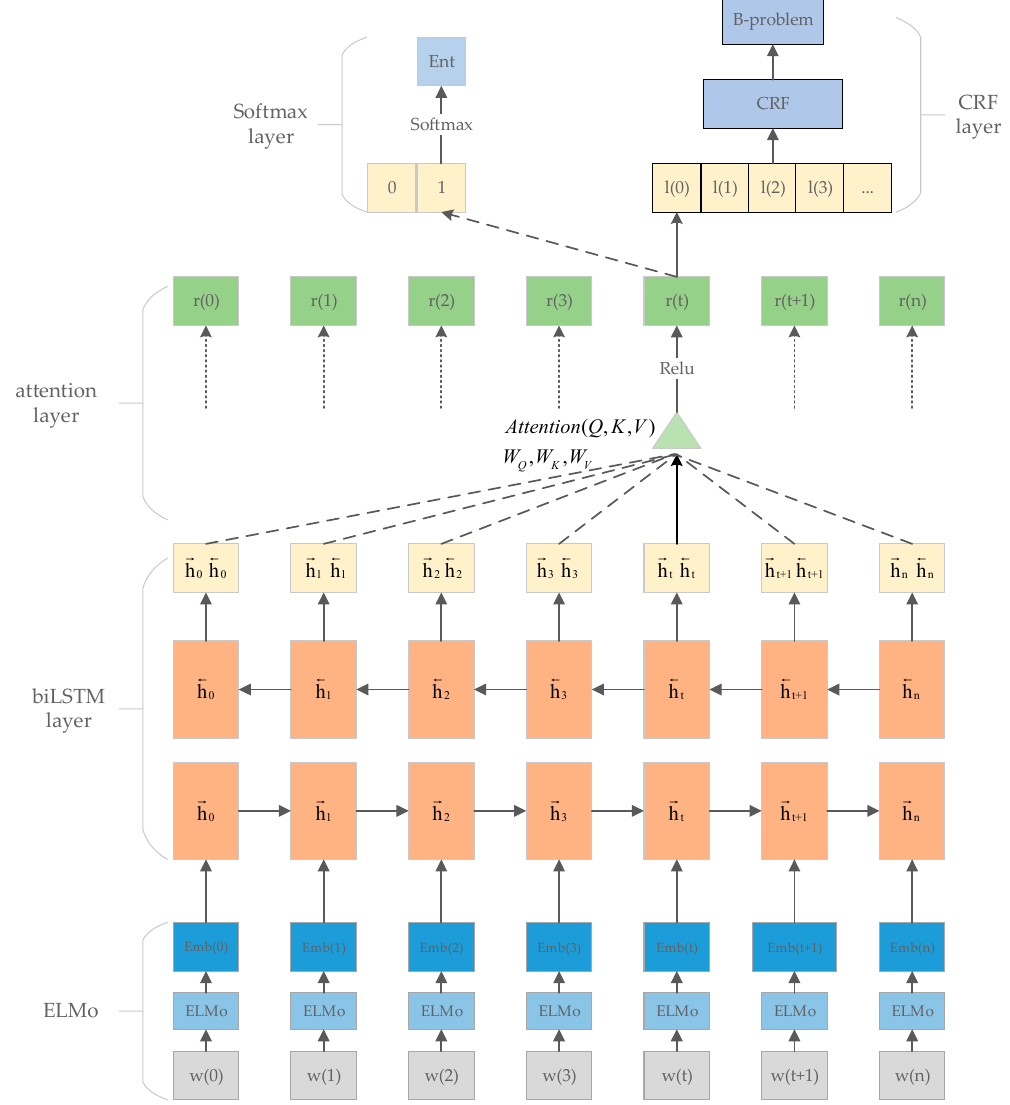
Figure 2. The architecture of our model. Firstly, the tokens in a sequence enter the pretrained Embeddings from Language Models (ELMo) model, and ELMo outputs the contextual embeddings of each token. Then, the Att-biLSTM layer receives the contextual embeddings and outputs the encoded vector of each token. At last, the encoded vectors are sent to the softmax layer to conduct the entity discovery task and to the Conditional Random Field (CRF) layer to decode the sequential labels synchronously.